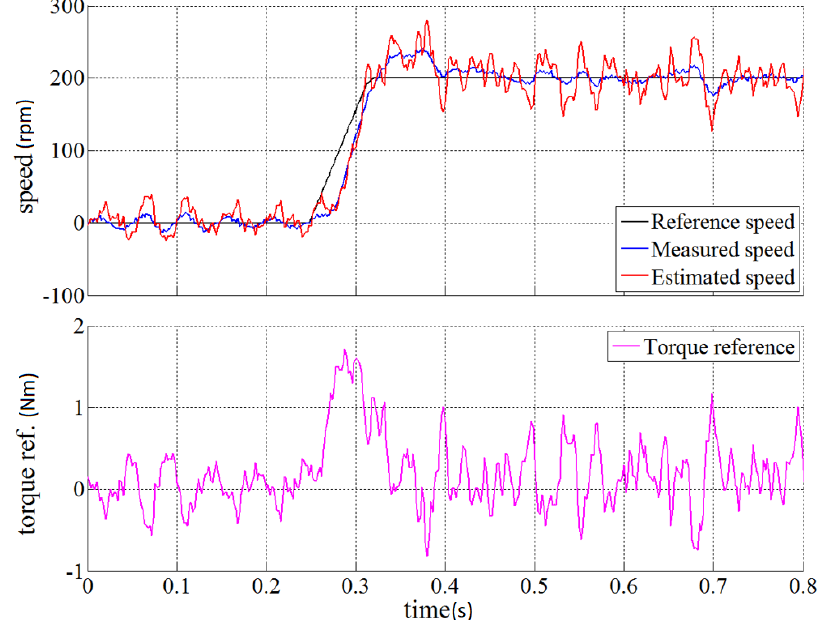
Figure 21. Motor #1: Increased bandwidth sensorless speed control (MTPA), startup from 0 to 200 rpm, typical (no adaptation) rotating voltage injection (70 V), no load.